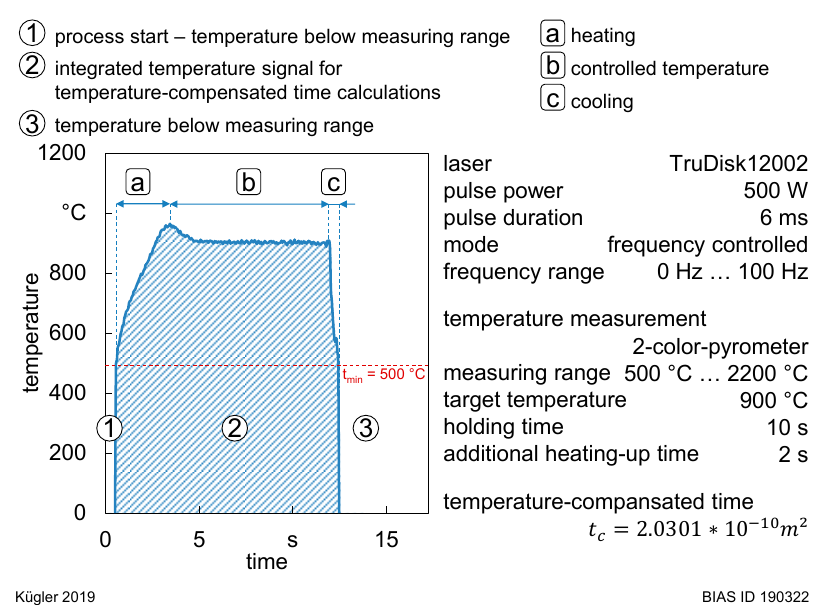
Figure 1. Example of temperature profile for the calculation of the temperature-compensated time .